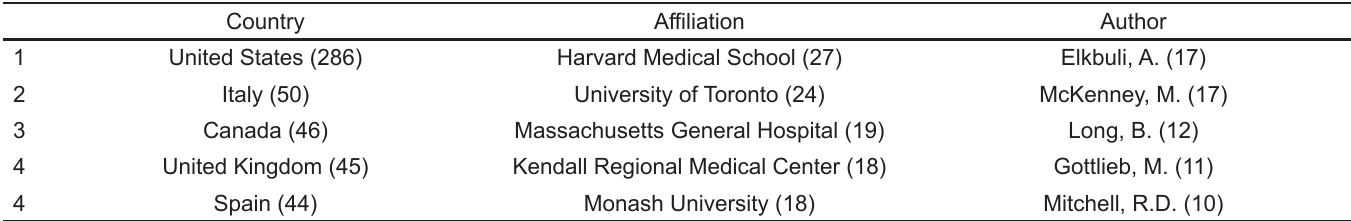
Table 2. Leading countries, affiliations, and authors of coronavirus disease 2019 publications (publication numbers in brackets).